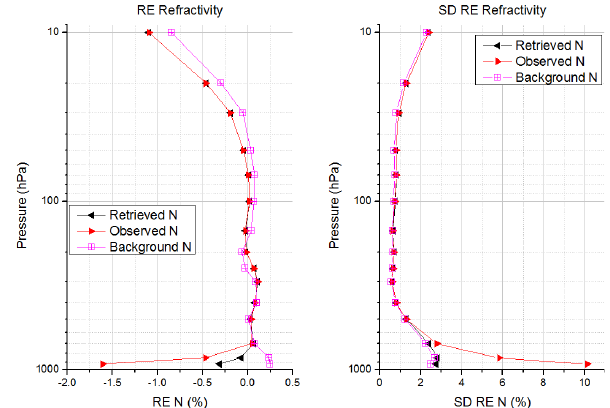
Fig. 6. Relative error and SD between the refractivity from the ra- dio occultation observation, retrieval product wetPrf, background ecmPrf and the refractivity calculated from radiosonde data, respec- tively.